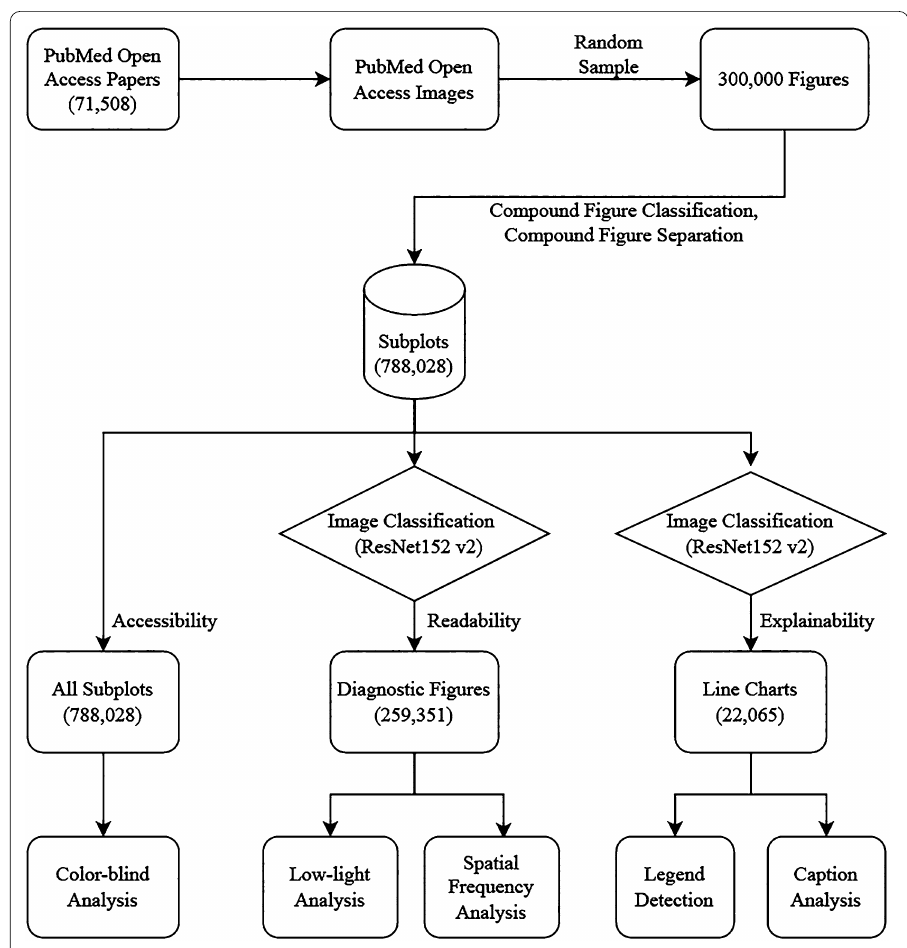
Figure 1 The data processing flow. We use deep learning techniques (ResNet152 v2 and YOLO v4) to detect compound figures, separate subplots, classify all subplots into image categories. Then we use computer vision, deep learning, and other techniques to detect color-blind unsafe figure, low light and contrast figures, and line charts with explainability issues